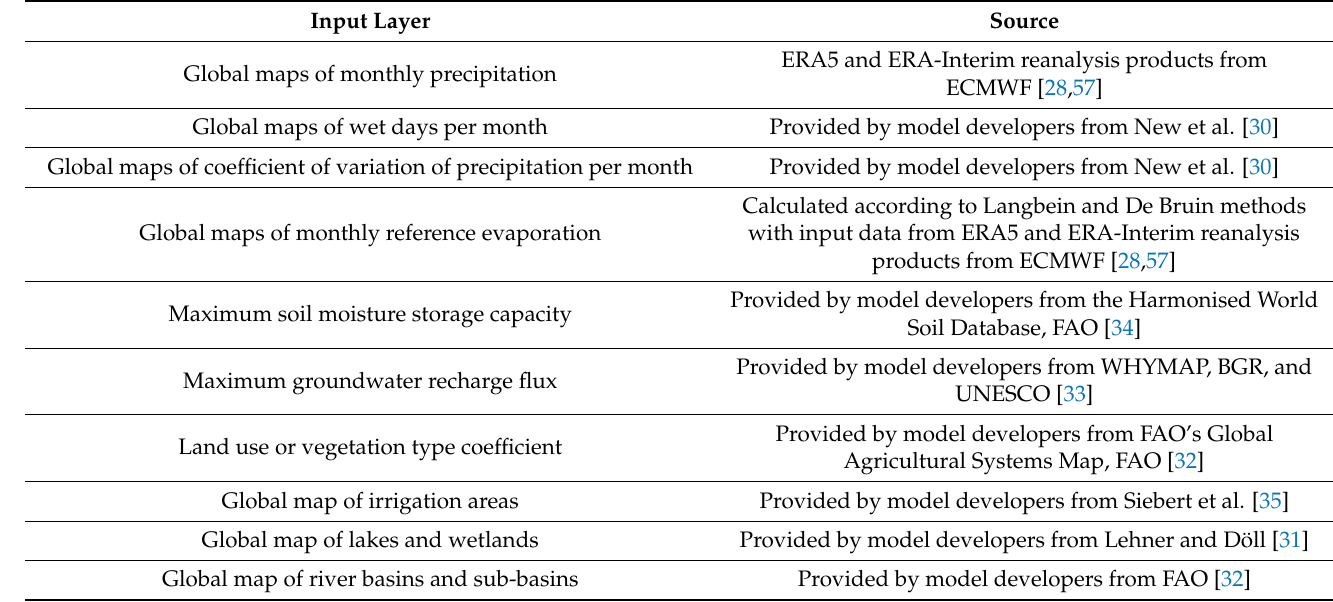
Table A1. GlobWat input layers and their